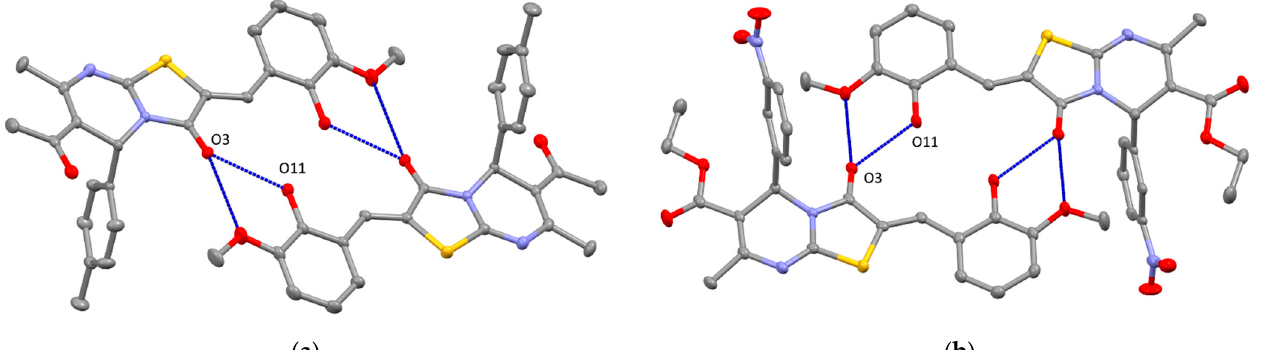
Figure 2. ORTEP-view of supramolecular dimers resulting from intermolecular H-bonding in crystals of compounds 1 ( a ) and 2 ( b ). The ellipsoids are presented with 50% probability and the H-atoms are omitted for clarity. H-bonding is presented by blue dotted